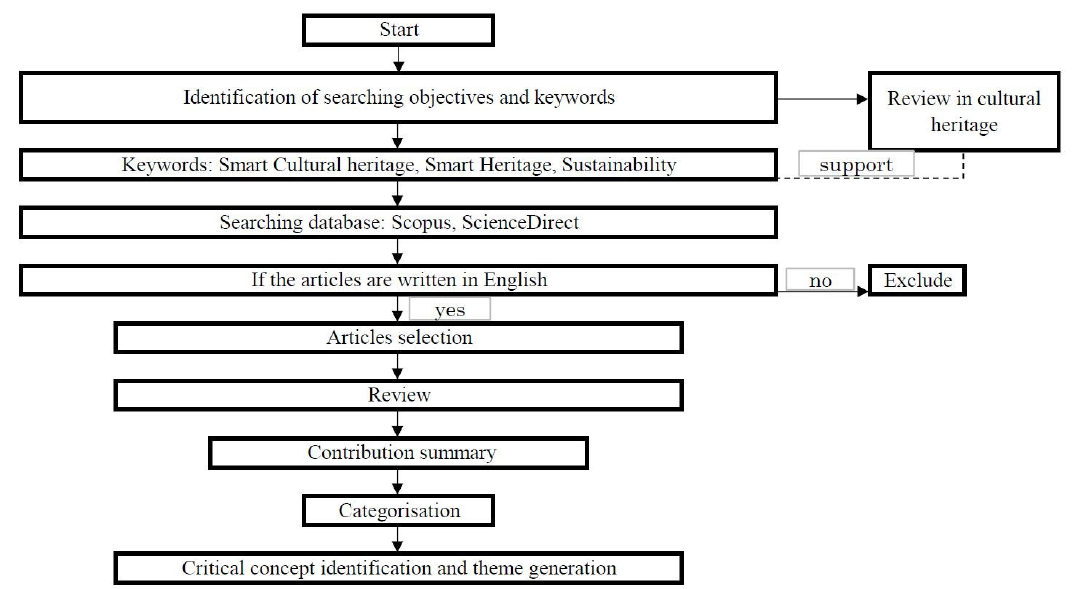
Figure 1. Article Selection